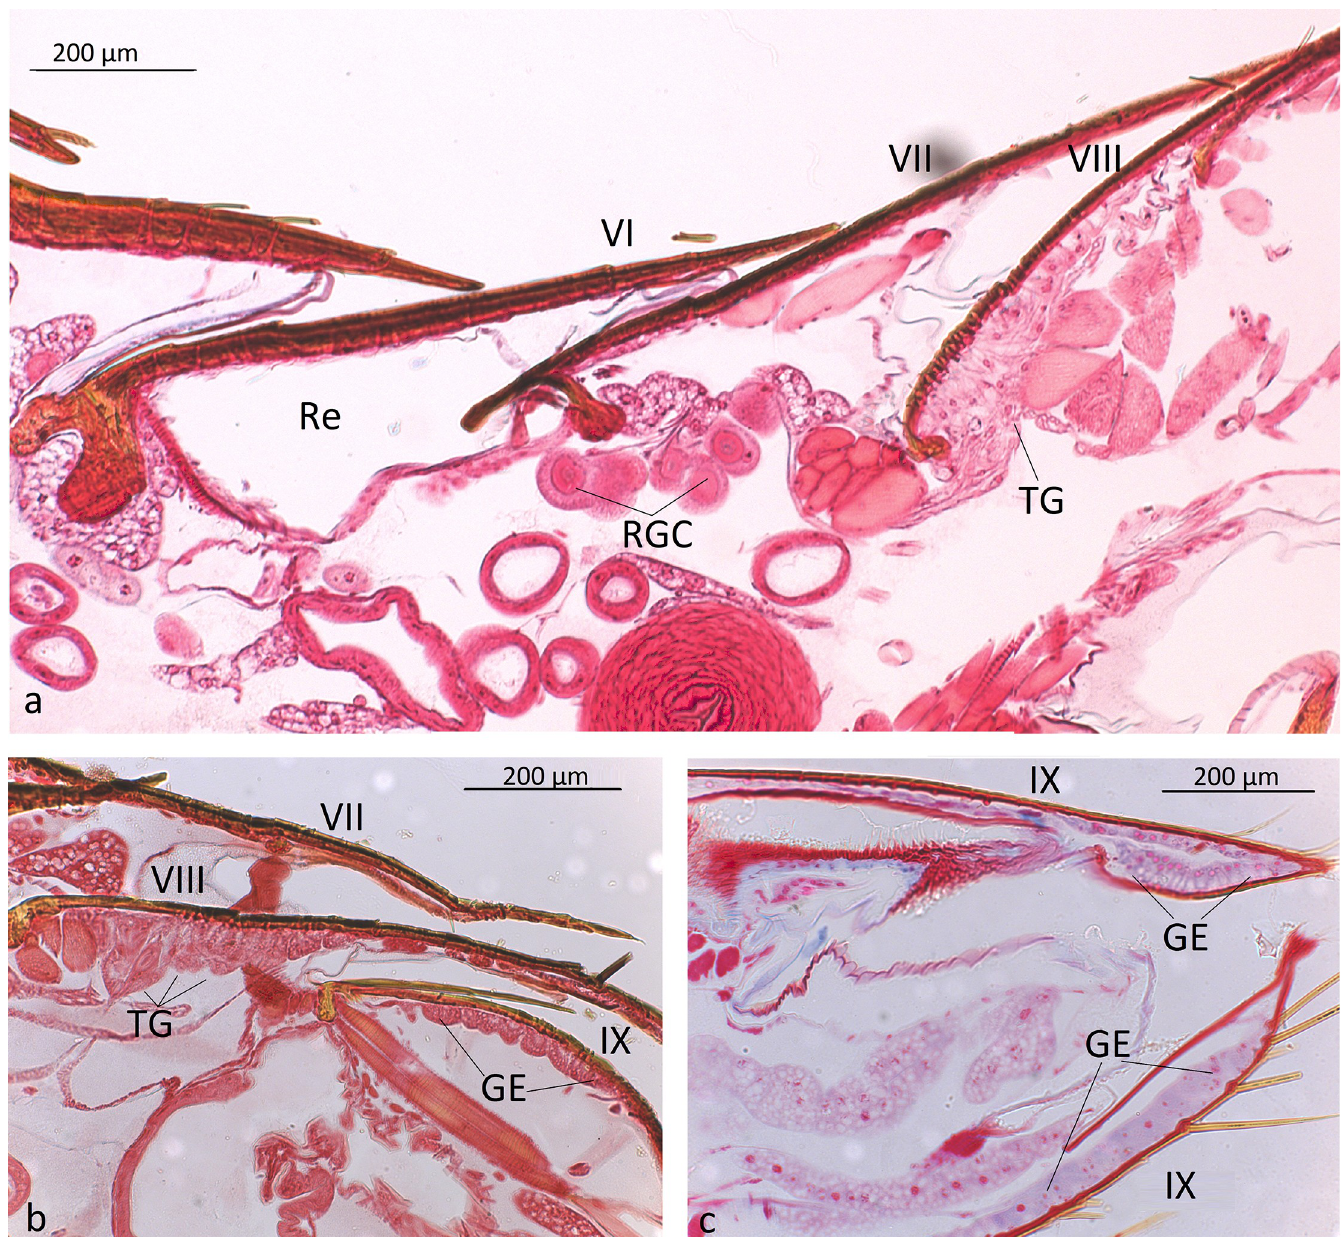
Fig 2. Longitudinal sections through the abdominal posterior segments of Dinarda dentata . a) Section through 6 th , 7 th and 8 th tergites, showing the repellent- defense tergal gland between 6 th and 7 th tergites. Re, reservoir of the repellent defense gland; RGC repellent gland cells; TG, parts of the tergal gland in the 8 th tergite. b) Sections through 7 th , 8 th , and 9 th tergites, showing the tergal glandular epithelium (GE) in the 8 th tergite and c) in the 9 th tergite and sternite.